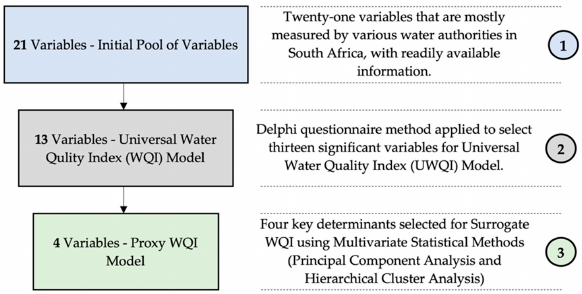
Figure 4. Flow diagram illustrating the two-stage screening process employed for selecting the significant water quality parameters. Source: Umgeni water quality data. Notes: statistical analysis was performed using water quality dataset from Umgeni Water Board monitored from January 2012 to July 2018.